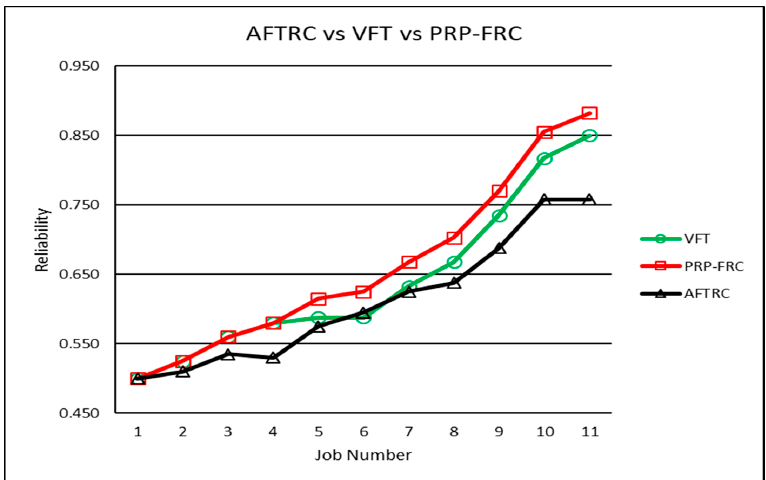
Electronics 2019 , 8 , x FOR PEER REVIEW Figure 10. Reliability Rate for each architecture. Figure 10. Reliability Rate for each architecture. Figure 10. Reliability Rate for each architecture.